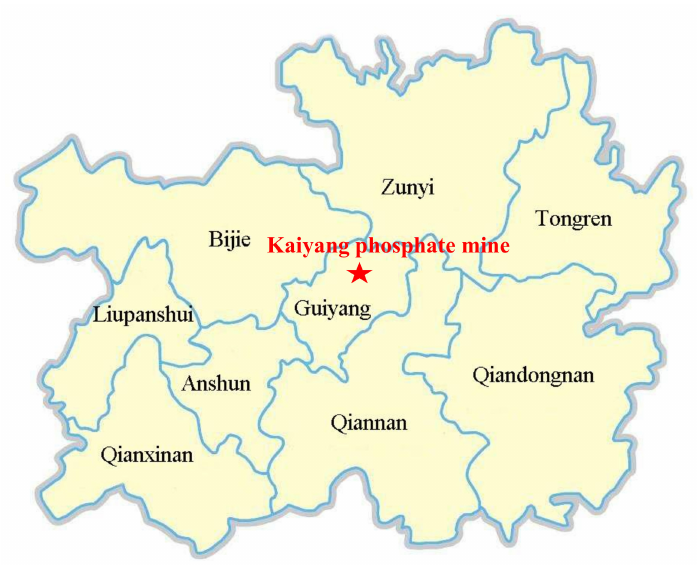
Figure 3. Location of the Kaiyang phosphate